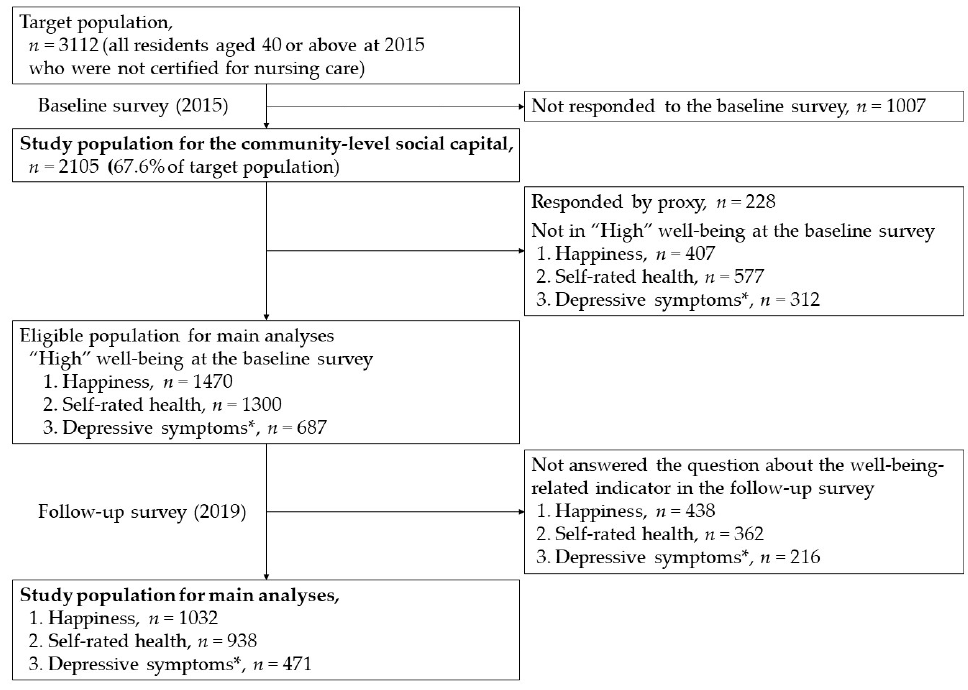
Figure 1. Study population. * Depressive symptoms were assessed for those aged 65 or